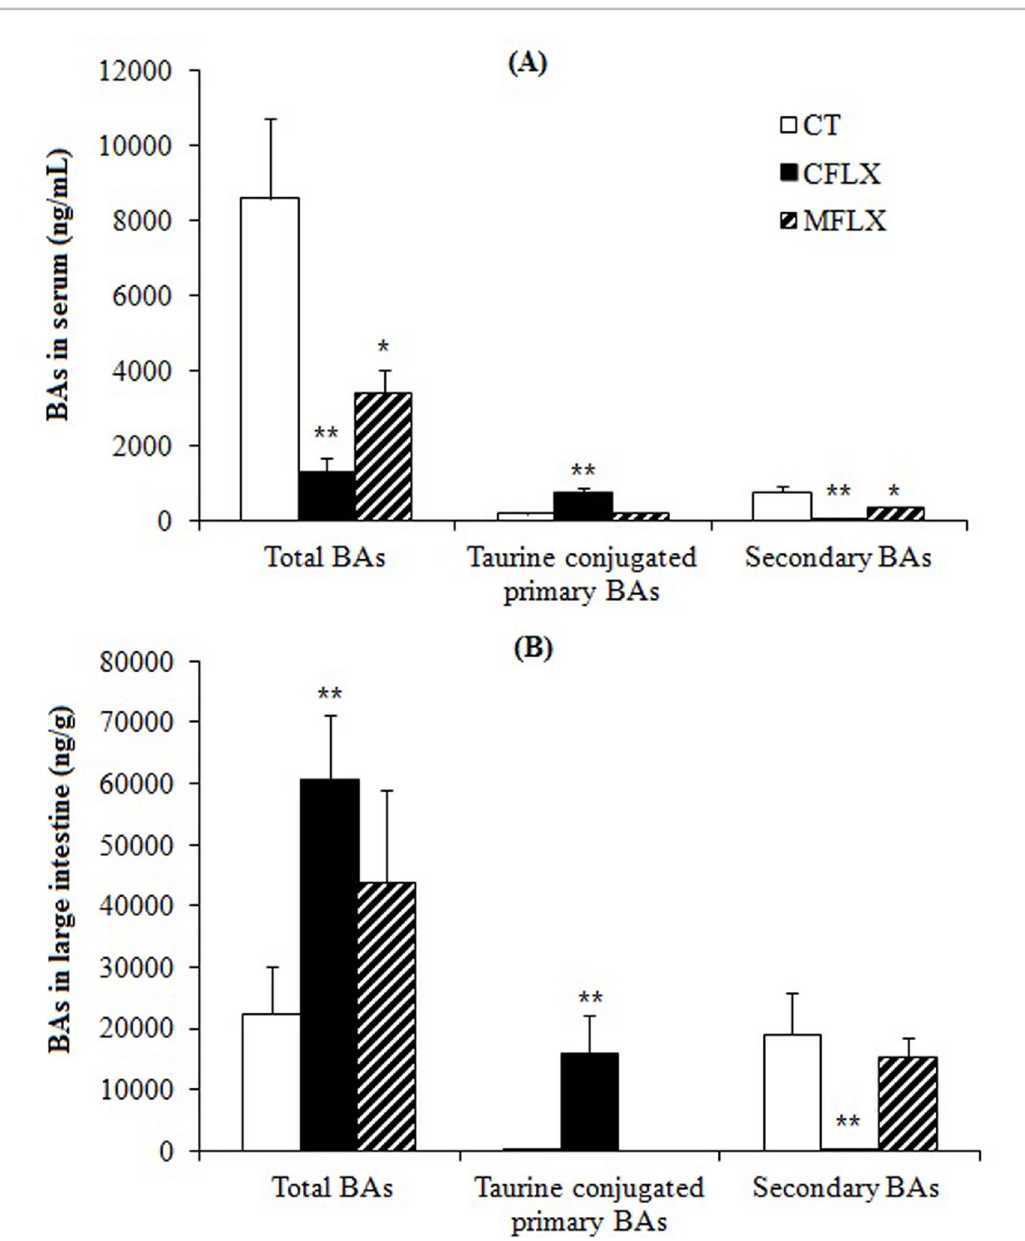
FIGURE 1 - Total BAs, taurine-conjugated primary BAs, and secondary BAs concentrations in serum and large intestine of normal rats treated with 100 mg/kg/day ciprofloxacin and 40 mg/kg/day of moxifloxacin orally for seven days. Data are expressed as the mean ± S.E.M (n = 5). * p < 0.05, ** p < 0.01 vs. CT